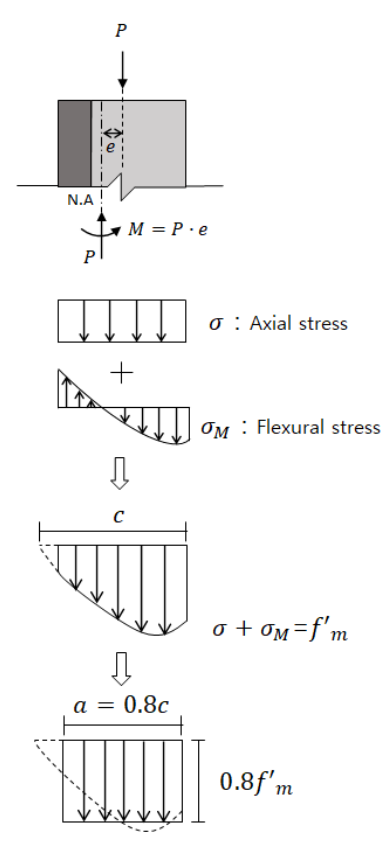
Figure 13. Stress distribution for strengthening on one side for compressive strength test.